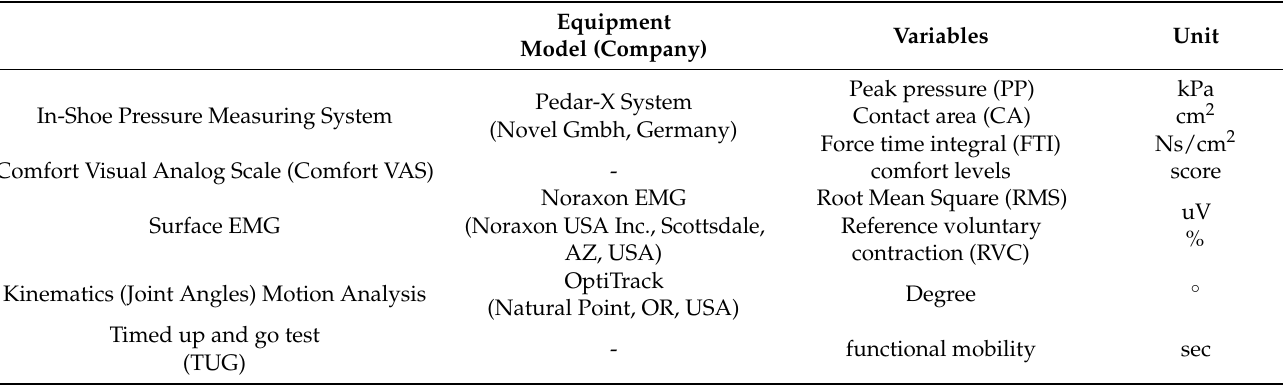
Table 1. The experimental equipment used to determine the influence of the designed insole on walking, as well as the shock absorption effect.